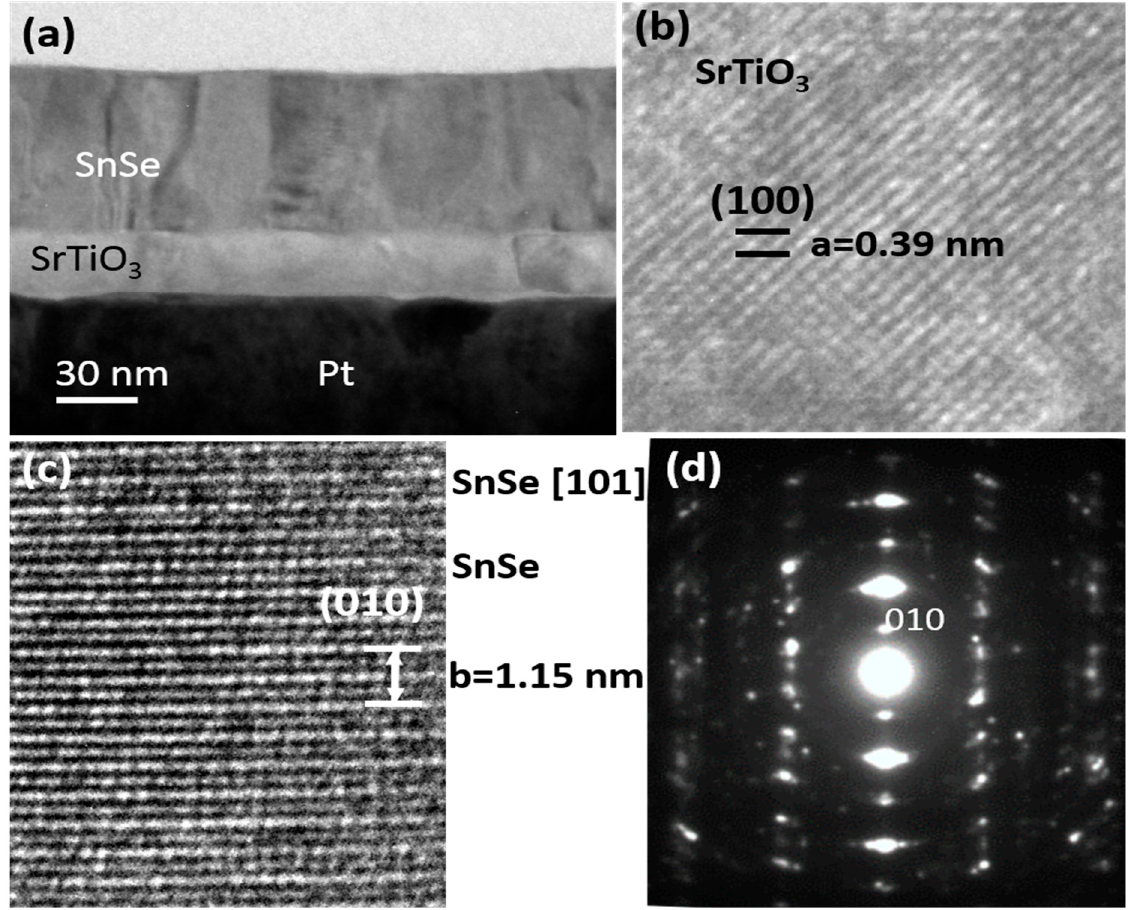
Figure 2. ( a ) A cross-sectional TEM image of a heterostructure device where the SnSe and STO layer can be clearly identified. ( b ) HRTEM image showing the crystalized structure of STO, HRTEM image ( c ), and diffraction pattern ( d ) of the SnSe layer viewed along the [101] direction. The resistive switching characteristics of the Cu/SnSe/STO/Pt and Ag/SnSe/STO/Pt memory cells were investigated by voltage sweeping I–V curve measurements and the results are shown in Figure 3a,b. Generally, by steadily increasing the positive voltage imposed on the device from 0 V to a certain positive voltage, the device changes from a high